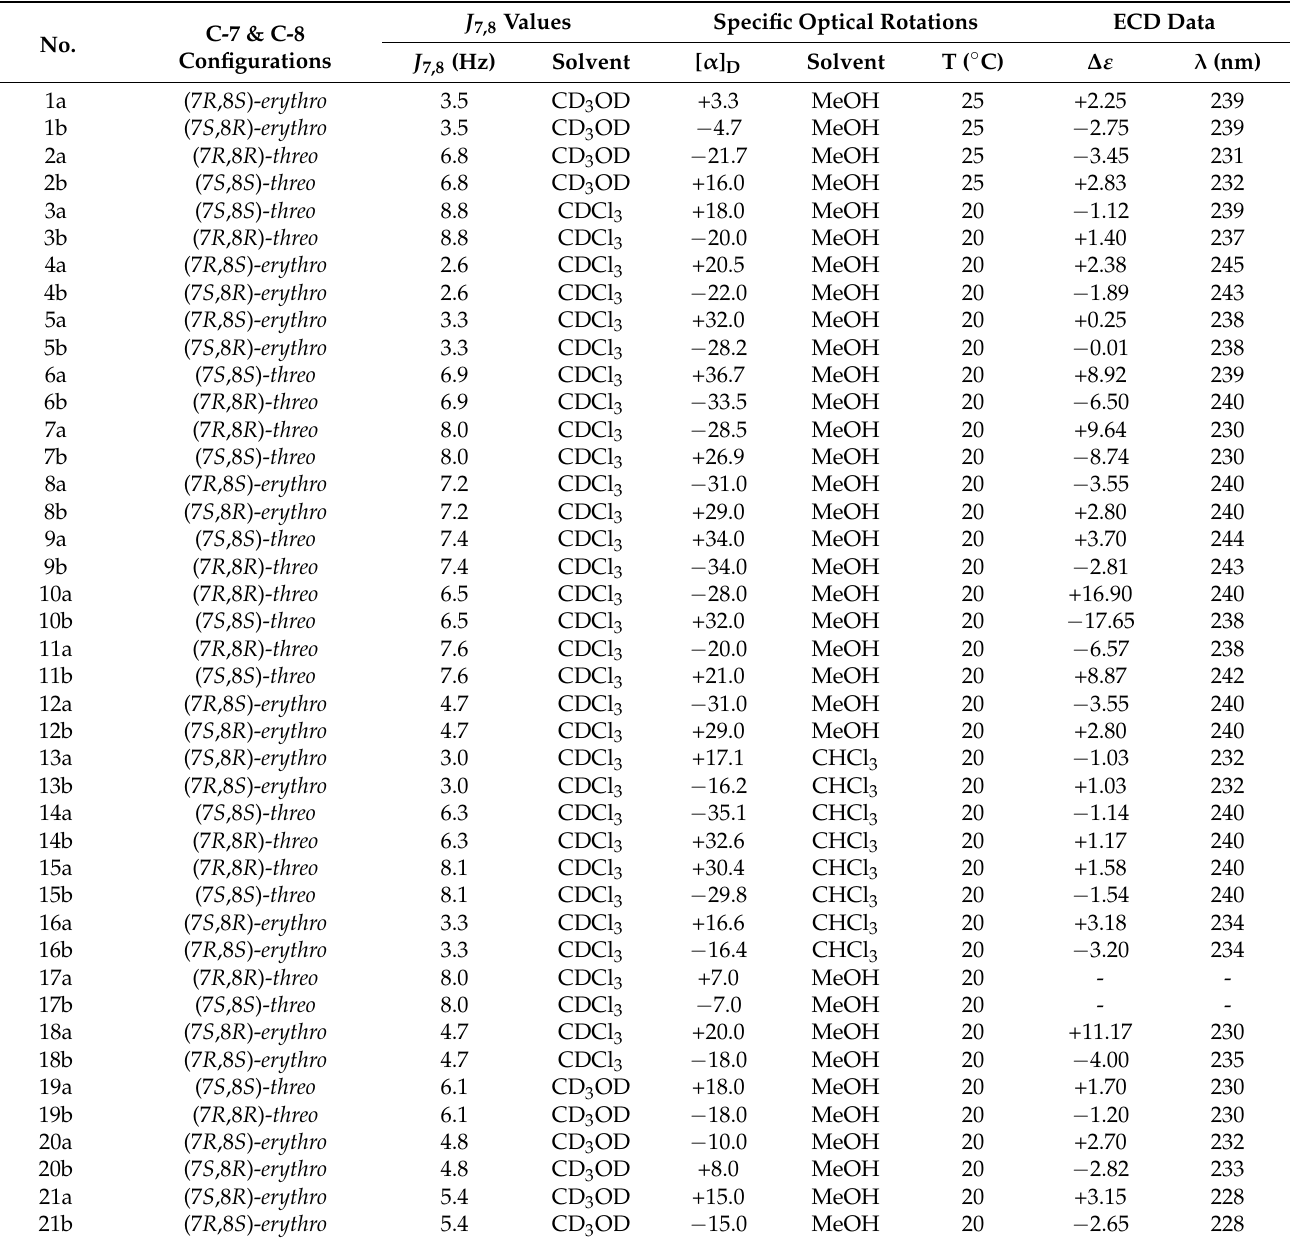
Table 1. J 7,8 Values, specific optical rotations and ECD data of 8,4 (cid:48)